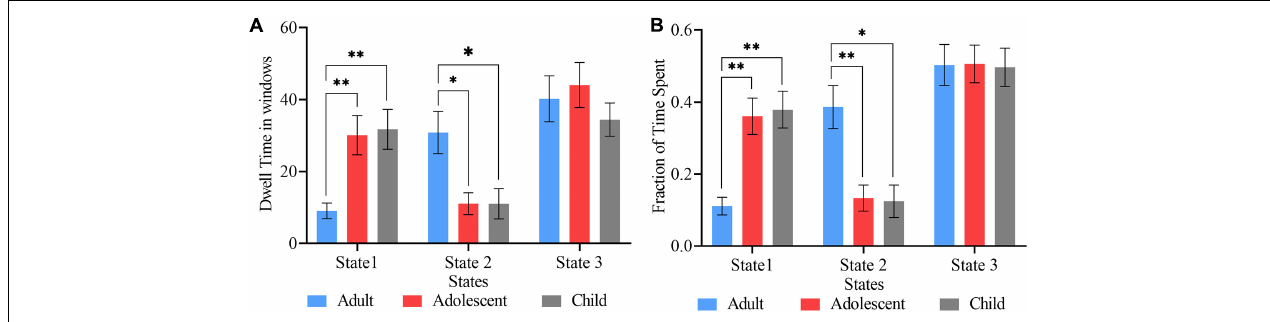
FIGURE 4 | State vectors for temporal analysis. (A) Mean dwell times in the three cluster states. (B) Fraction of time spent by each group in the three states. The blue, red, and ash bars represent adult, adolescent, and child ADHD patients, respectively. Asterisk indicates P < 0.05, FDR corrected and two asterisks indicate P < 0.001, FDR